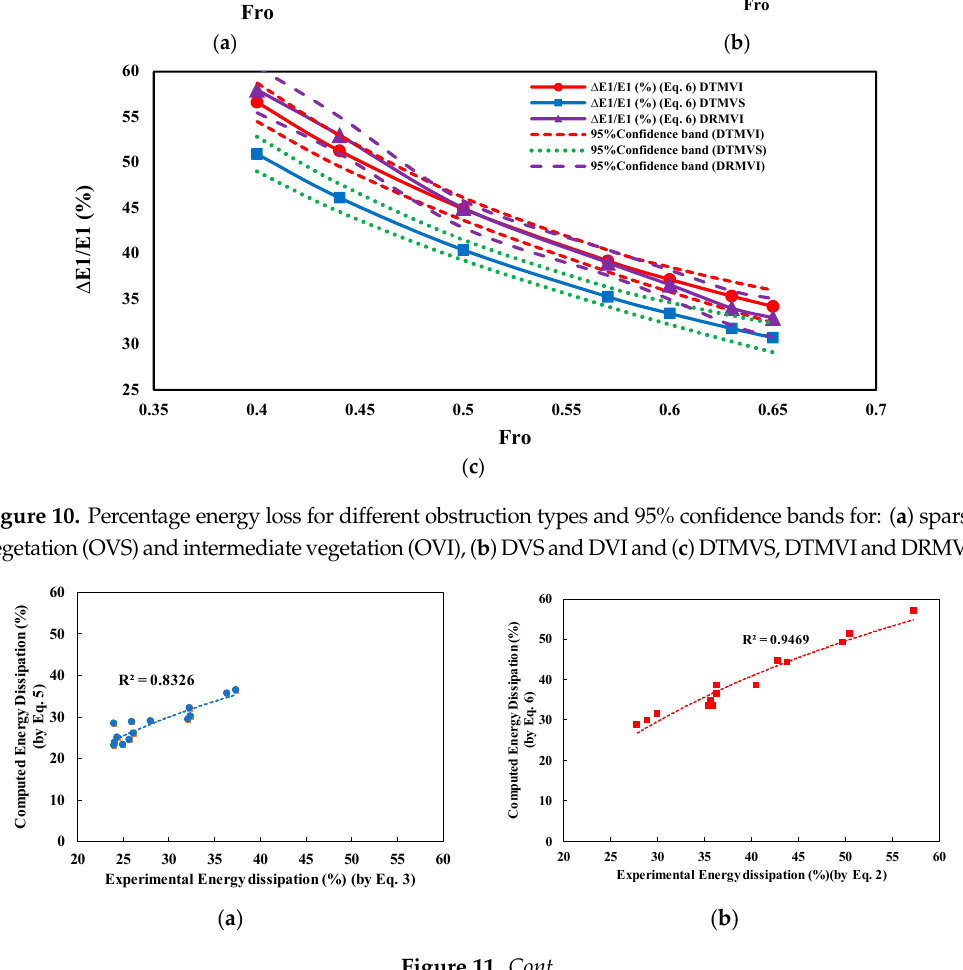
Experimental Energy dissipation (%) (by Eq. 3)